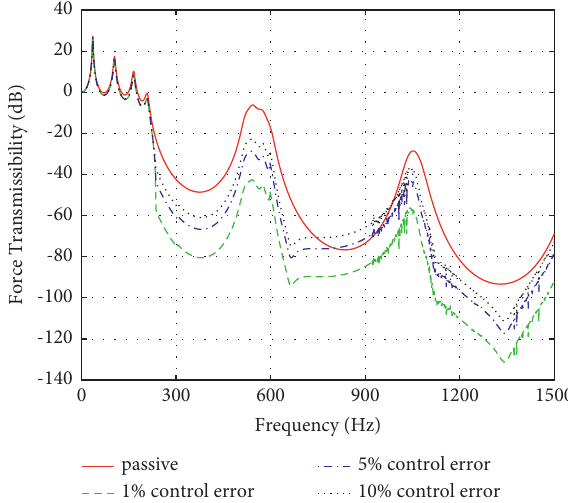
Figure 13: Minimum force transmissibility of PSPS with control